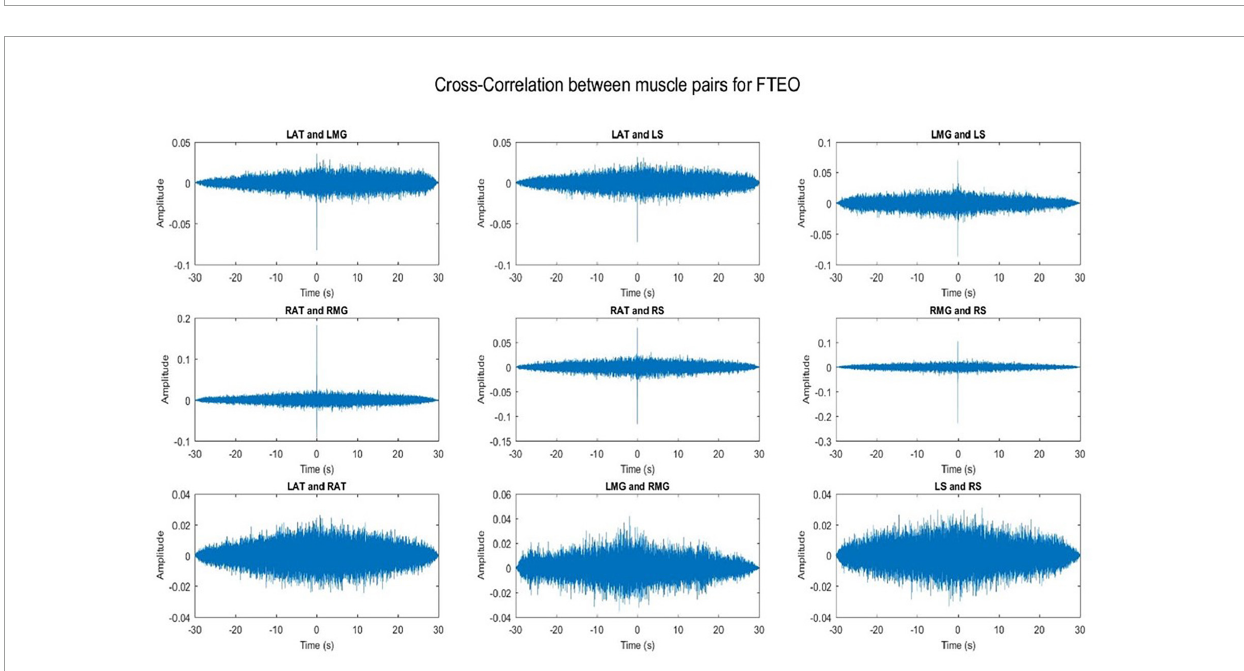
FIGURE2 Cross-correlation of different muscle pairs under FTEO condition for a single participant for a single trial. The figure represents cross-correlation between the EMG signals of different muscle pairs under the most stable postural position. It shows negligible cross talk between the muscle